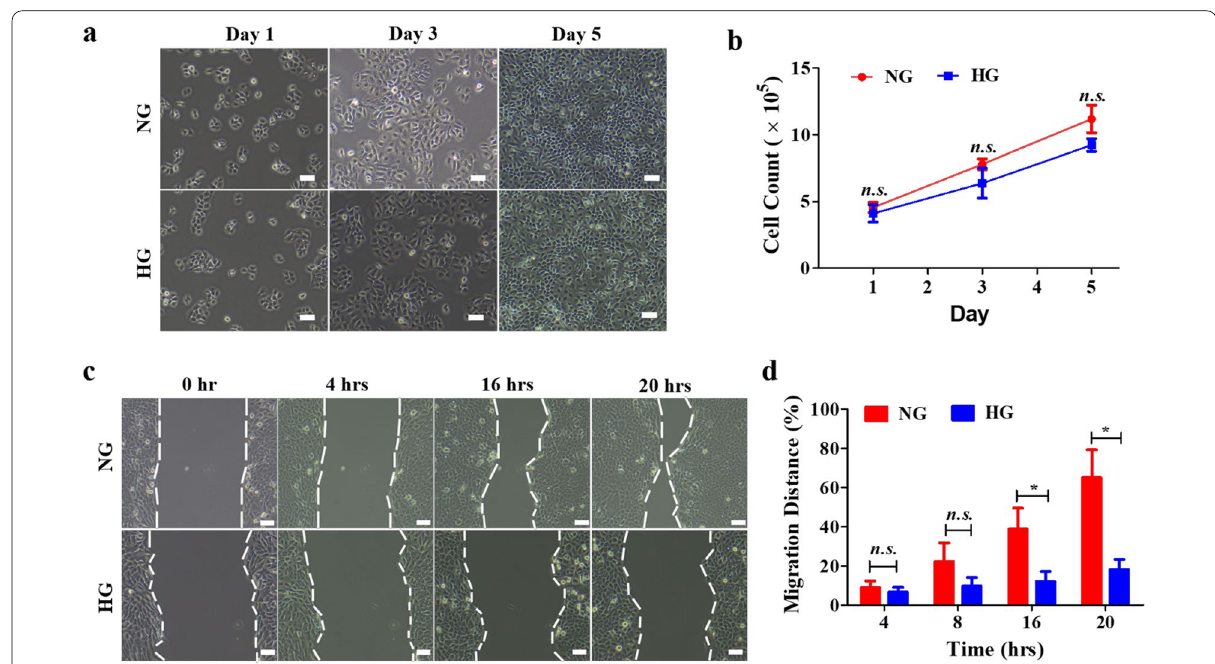
Fig. 1 Proliferation and migration of HaCaT under normoglycemia and hyperglycemia conditions. Human keratinocytes, HaCaT were cultured in normal glucose (NG) or high glucose (HG) media and a images were taken at Day 1, 3, 5 after seeding (scale bar, 100 μm). b Viable cell counts of either culture throughout the 5 days of culturing were determined. c Time lapse images showing the migrated distance of HaCaT cultured in either NG or HG media (scale bar, 100 μm), and d the statistical analysis of the migrated distance of the two groups. *, P < 0.05; n.s. not